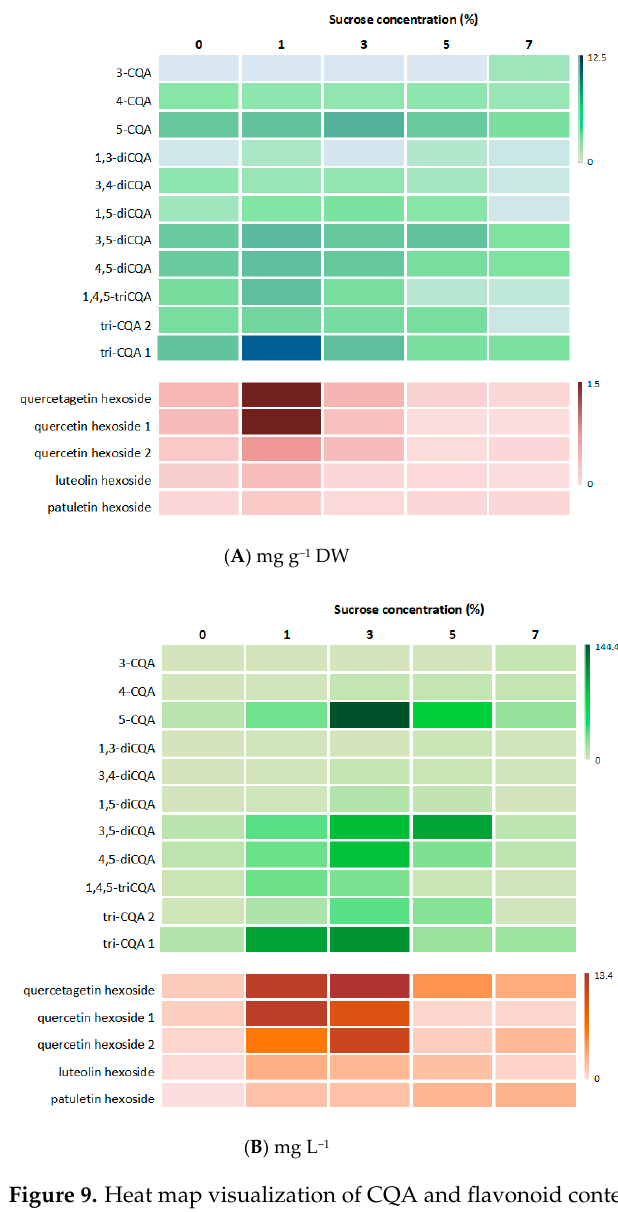
Figure 9. Heat map visualization of CQA and flavonoid content in ( A ) mg g − 1 DW and ( B ) mg L − 1 in R. carthamoides transformed roots cultured in liquid WPM medium supplemented with different sucrose concentrations (0–7%). Lighter colored boxes indicate a lower metabolite content. Darker colored boxes indicate a higher metabolite level.